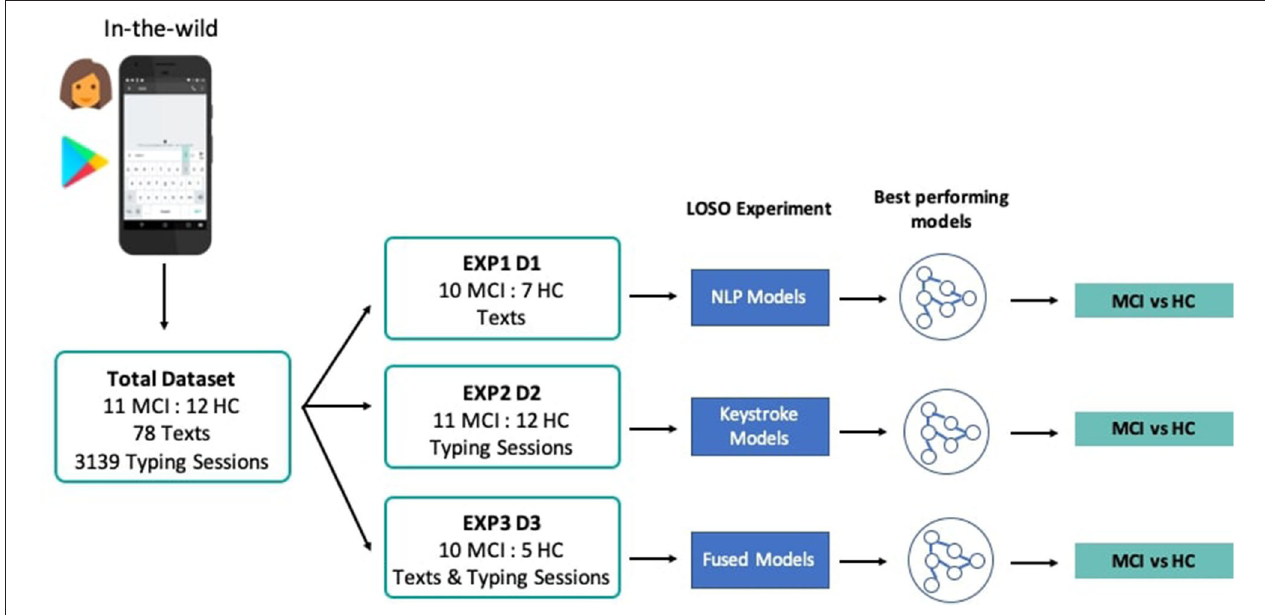
FIGURE 3 | System pipeline and experiments’ overview. Texts and typing sessions were collected from MCI patients and HC through the custom keyboard of the TypeOfMood application in a non-clinical setting. The total dataset was split accordingly (D1, D2, D3) to the needs of the three experiments that tested NLP models (EXP1), keystroke models (EXP2), and models with fused feature sets (EXP3). Multiple rounds of LOSO experiments yielded the best performing models to distinguish among MCI and HC.